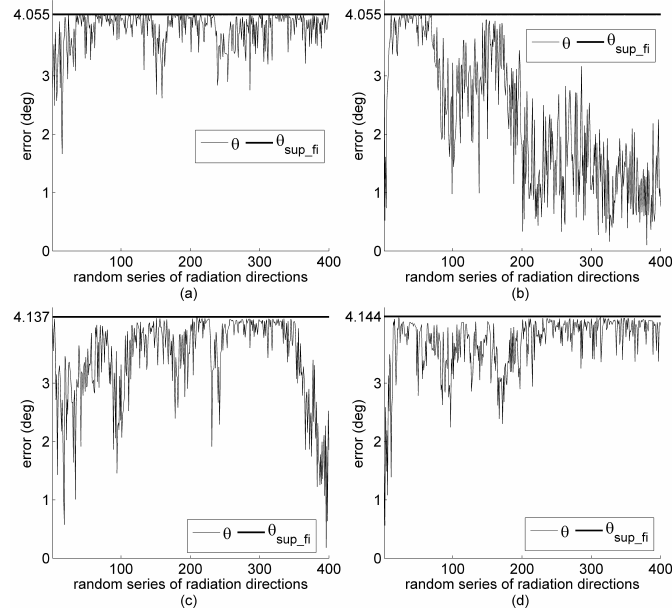
Figure 5. Simulated orientation error of sensor Arrays 2, 3, 4, and 5 in ( a – d ) under full interference impact when µ = 1 but with the same series of solar positions as in Figure